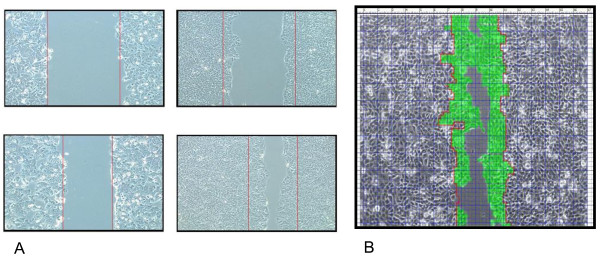
A+B. Migrating cells of the wound healing assay. (A) Migrating cells of the wound healing assay -/+ irradiation were presented as pictures (40 fold magnification, Axiovert 25, Carl Zeiss AG, Göttingen) 12 hours after irradiation. (B) The pictures were fused and the highlighted cells were counted.